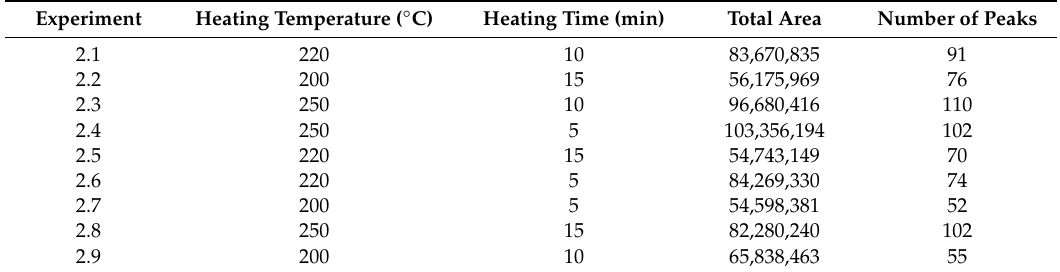
Table 5. Conditions, total area and number of chromatographic peaks obtained in each experiment of the 3 2 factorial design.